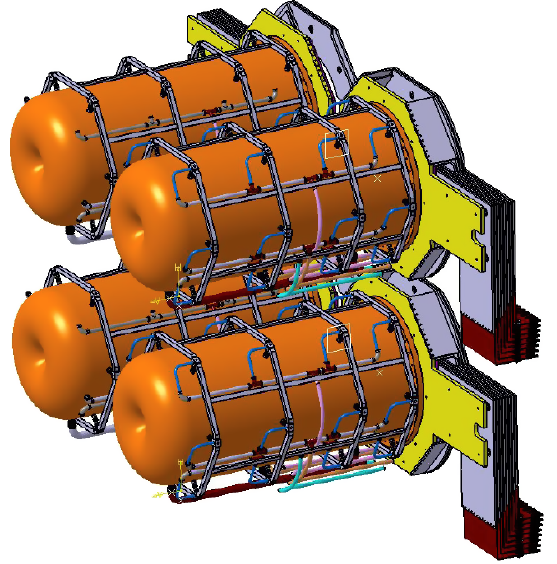
FIG. 3. Conceptual engineering design of the four target and horn system for the Super Beam.